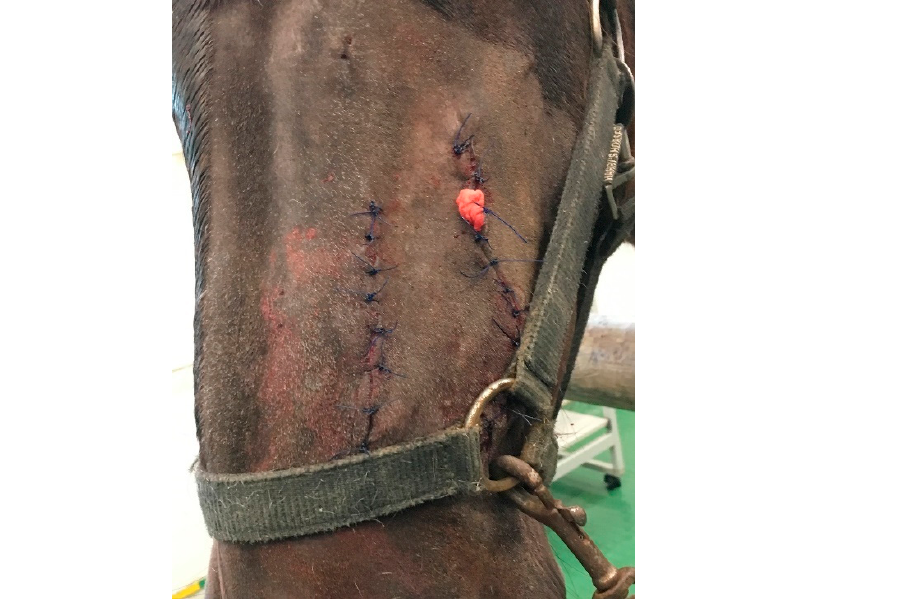
Figure 7. Postoperative view. Both incisions were closed with a simple interrupted suture. A drain was left in the wound after tooth extraction. It was removed 3 days after surgery, and no complications in healing were observed.